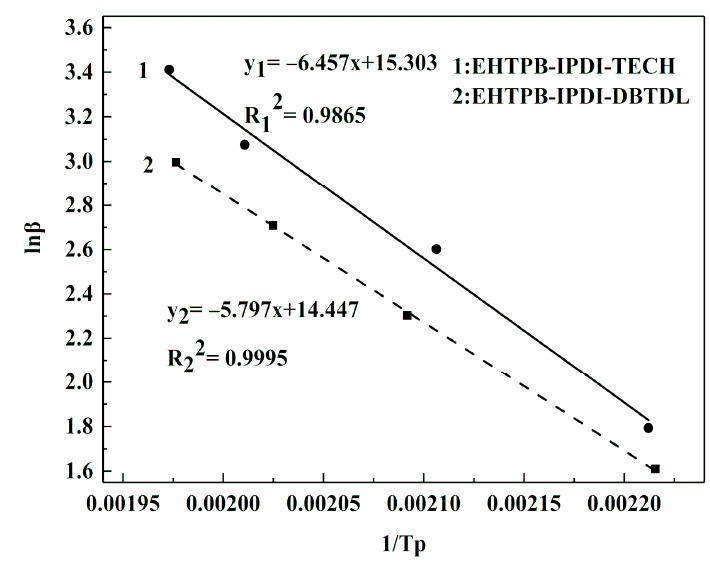
Figure 13. Linear fitting of ln β vs. 1 / T p for the EHTPB-IPDI-DBTDL and EHTPB-IPDI-TECH systems by the Flynn–Wall–Ozawa (F-W-O) equation.